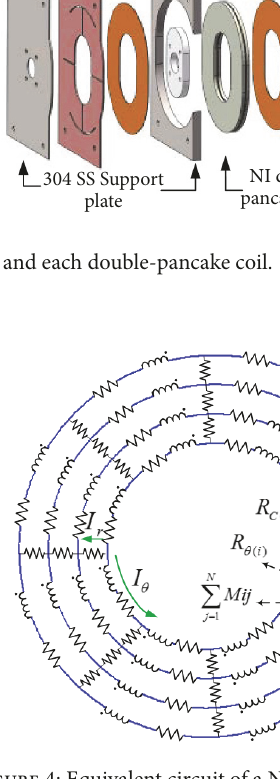
Figure 4: Equivalent circuit of a NI single pancake